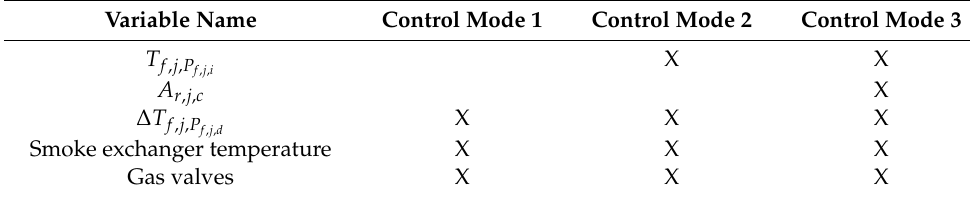
Table 8. Control modes characterization